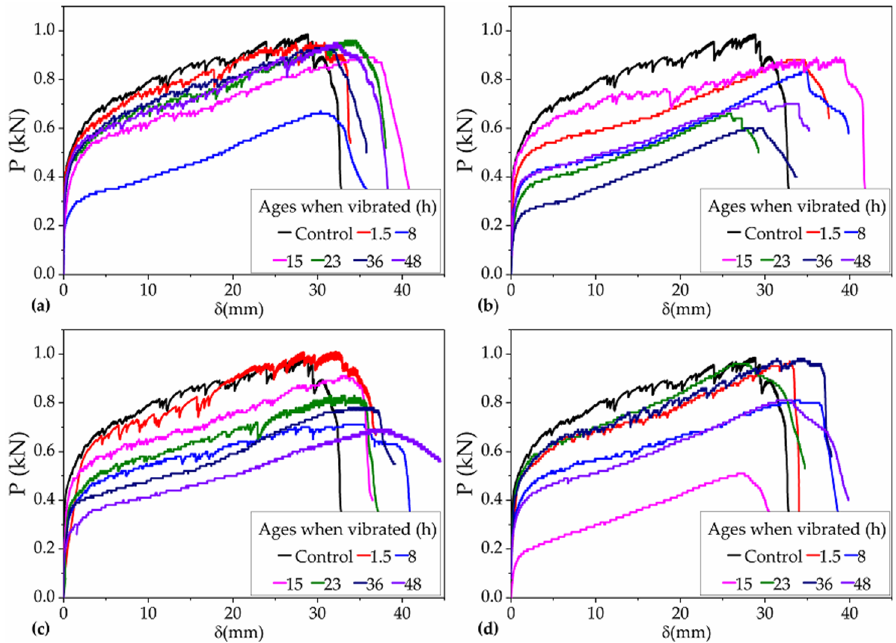
Figure 5. P– δ curves of all the 24 groups of specimens under the operating conditions for Var. 1 with frequencies of ( a ) 2 Hz, ( b ) 3 Hz, ( c ) 4 Hz, and ( d ) 5 Hz and that of the control group.